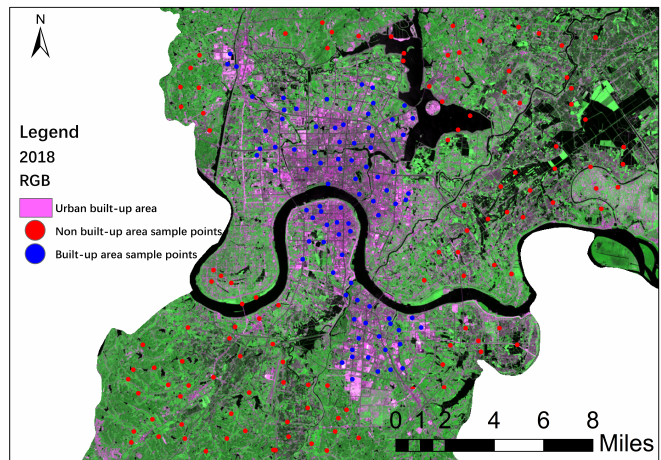
Figure 8. Sample of accuracy test